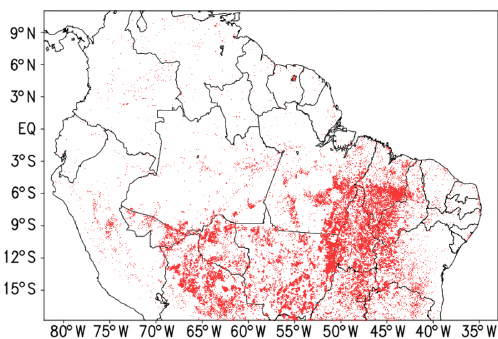
Figure 6. Burning points observed by the AVHRR sensor during September 2010 (source: